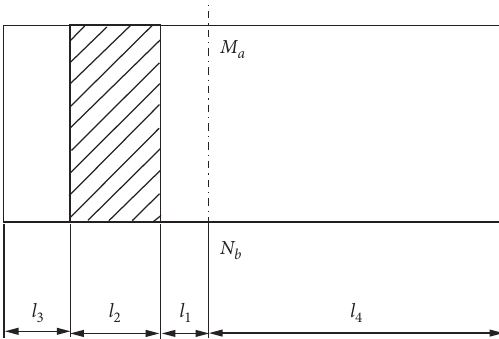
Figure 3: Nodal plane at the front cover plate.